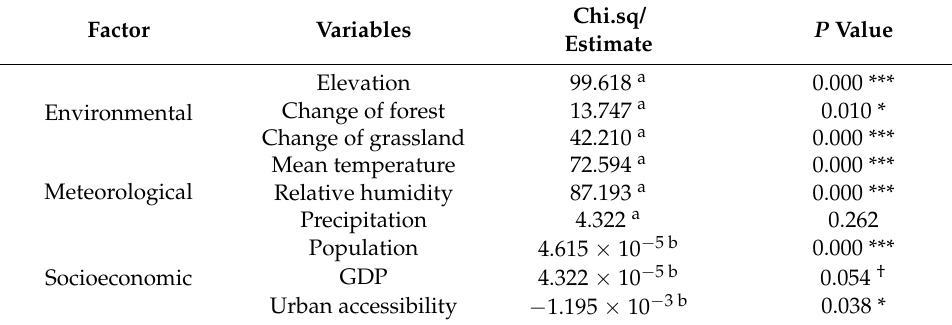
Table 4. Statistical results of spatial predictors based on the GAM model.